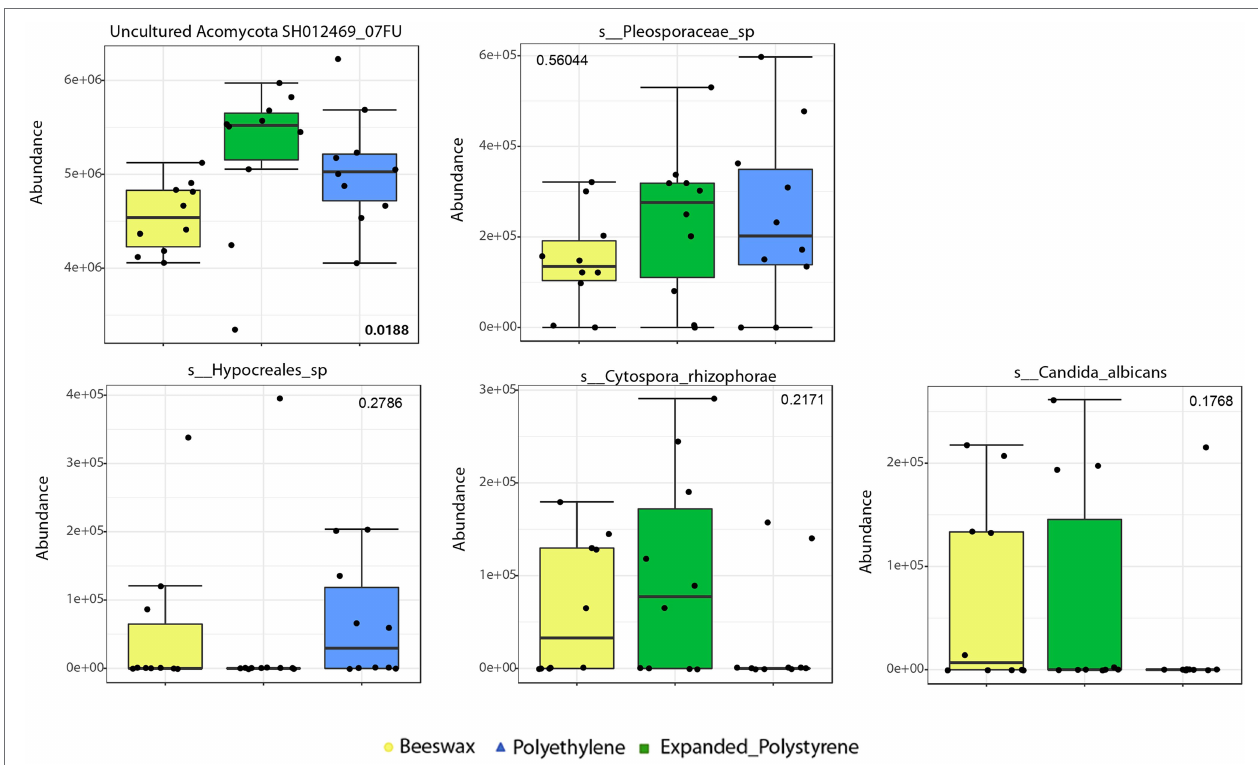
FIGURE 5 | Biomarker discriminant taxa analyses of fungal communities according to the treatment, via LEfSe, including only OTUs present in at least 50% of the samples. Taxa shown here correspond to genus level or to the lowest unclassified taxa. values of p are in some taxa added to the